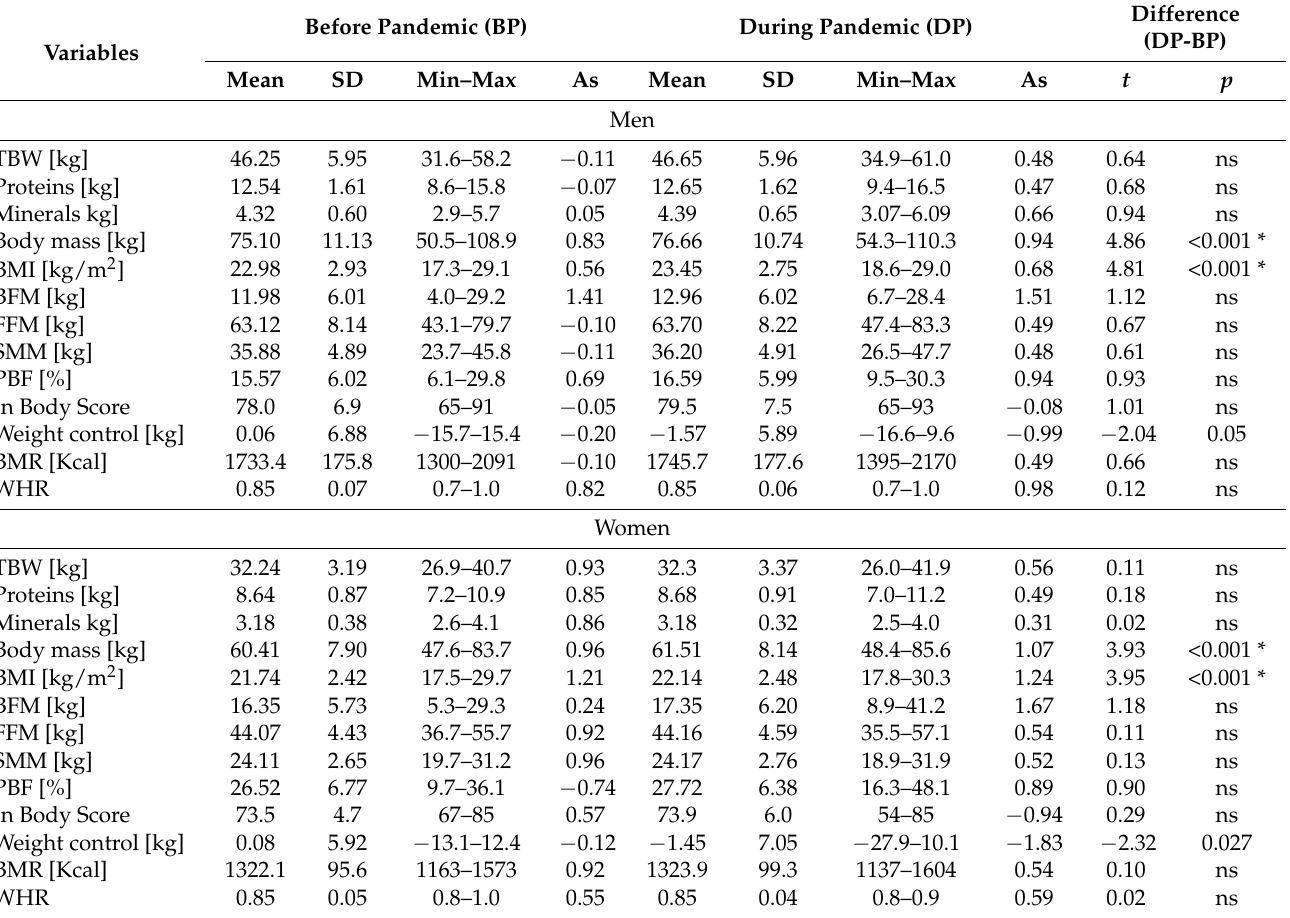
Table 4. Differences in the mean values of body composition parameters in men (N = 30) and women (N = 30) before and during the COVID-19